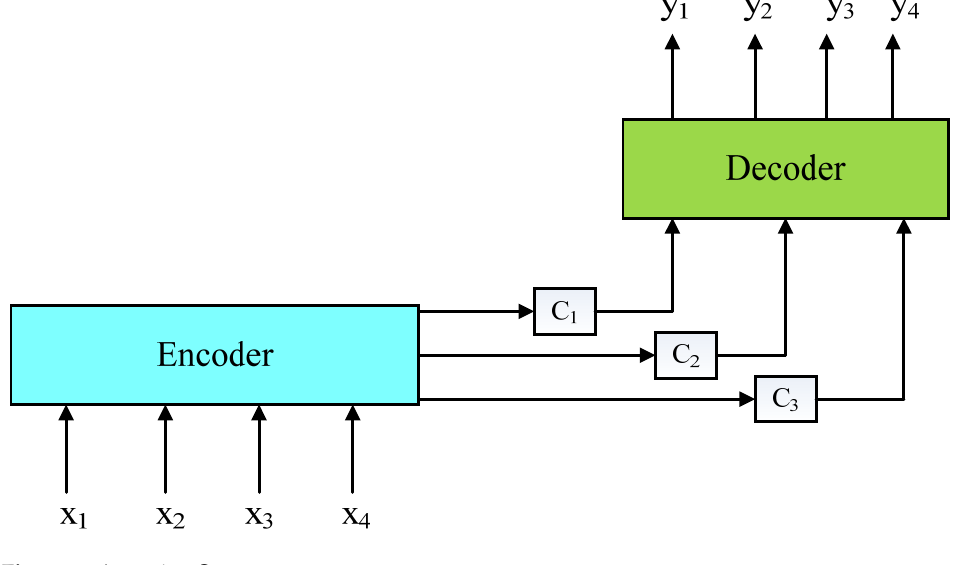
Figure 6. Attention